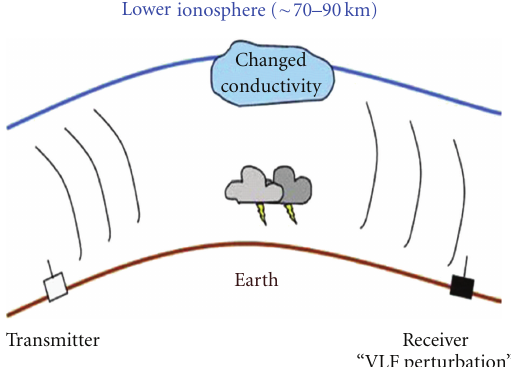
Figure 8: Diagram showing how the bottom side ionosphere and the mesosphere above a thunderstorm are probed by ground based transmitter, credit